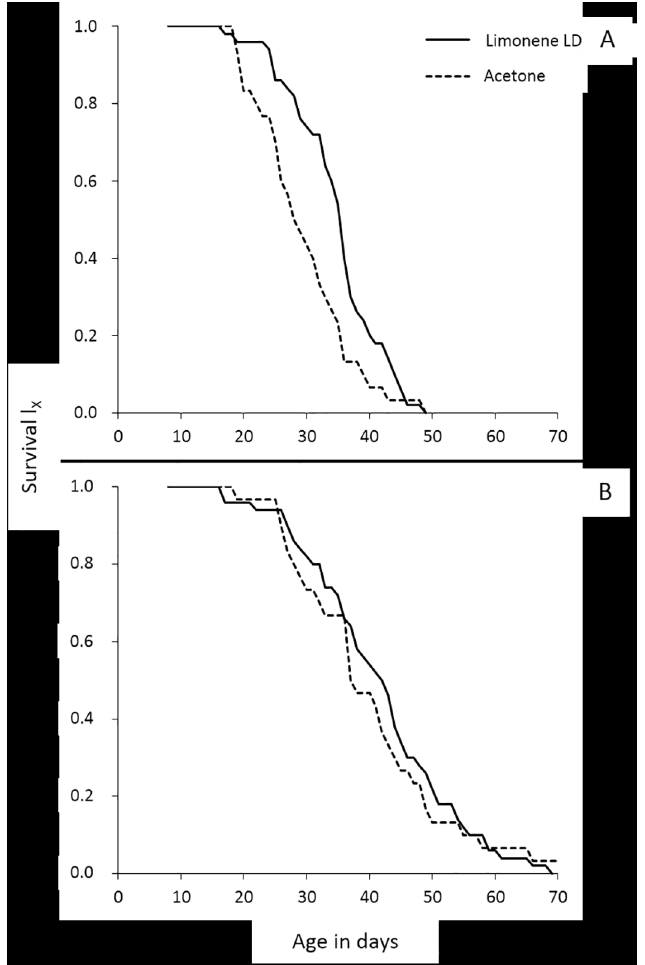
Fig 2. Age-specific survival curves for males that fed with S (A) or YS (B) and were subjected to limonene LD 20 or to pure acetone